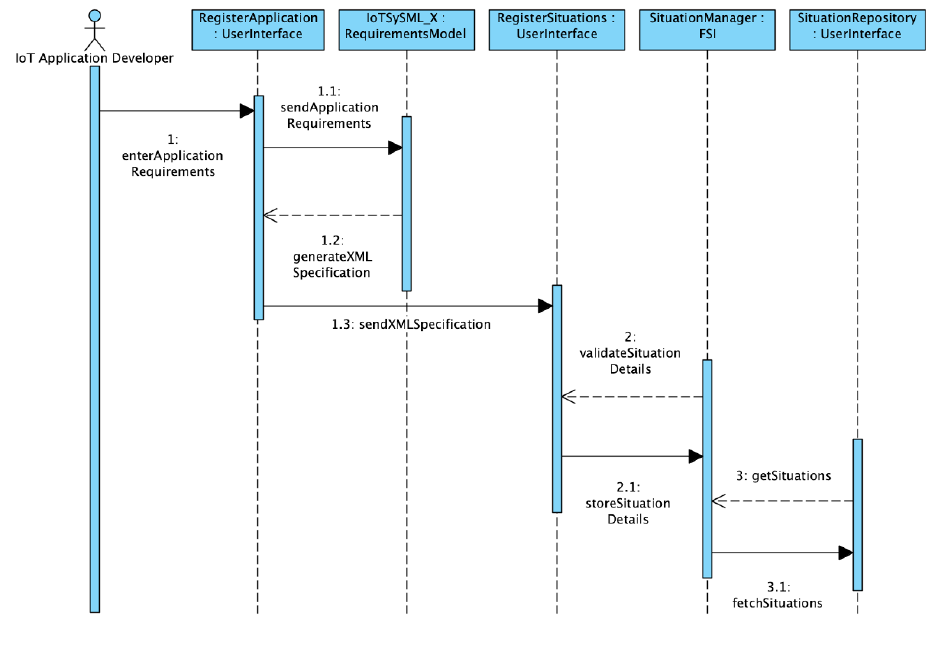
Figure 10. Registering